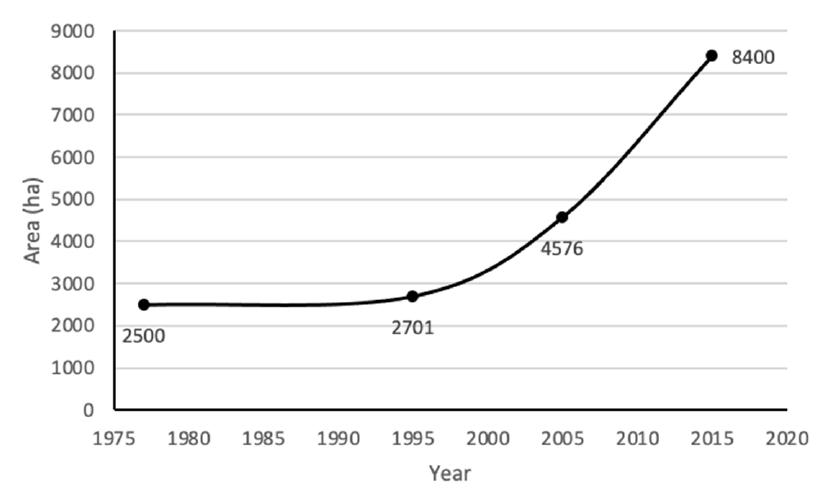
Figure 1. Evolution of the area occupied by Acacia dealbata (adapted from [14–16]).